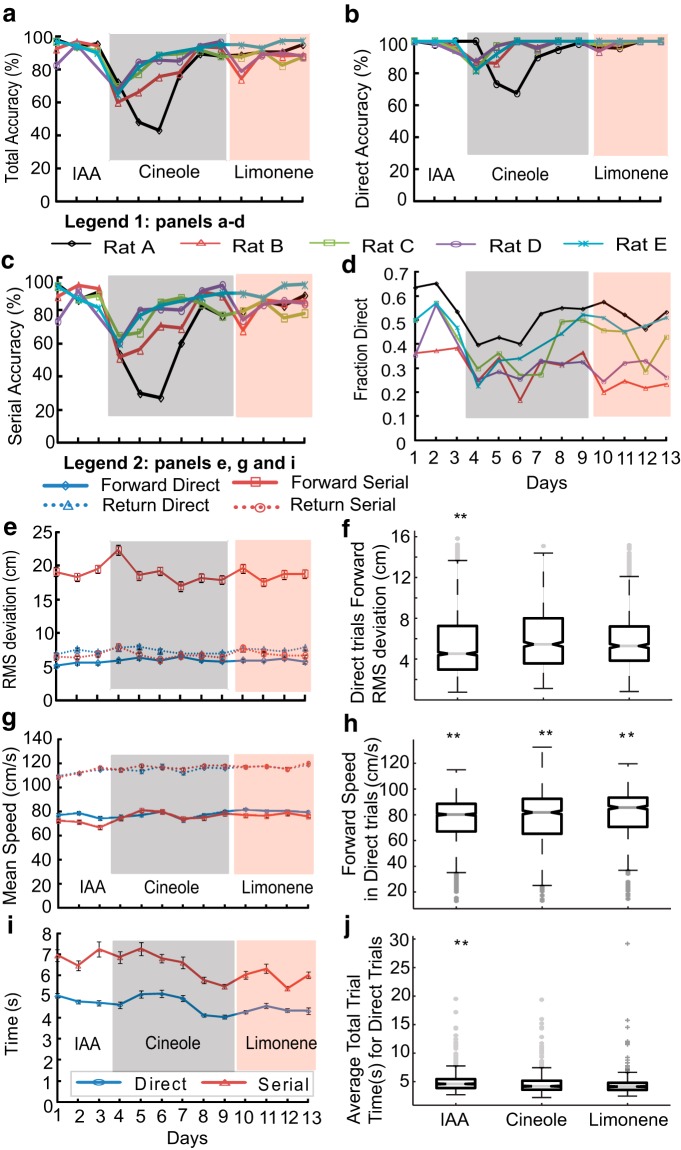
Rats rapidly learn to track novel odors. a–d, e, g, i, The white region represents baseline (IAA) odor delivery; gray region represents Cineole, and red represents Limonene. a, Total tracking accuracy. There is a major drop on introduction of cineole, a smaller one for limonene. b, Success rate in direct trials. There is a drop only in the first few days with cineole. c, Similar plot as b for serial trials. There is a big drop at the start of cineole. d, Fraction of trials using direct tracking for all rats. This drops toward chance during the initial few days with cineole. e, Average RMS deviation across all days for all rats. There is remarkably little increase for forward direct trials. f, Whisker box plot of RMS deviation in forward direction for direct trials. Data is pooled for all rats. Nd (IAA) = 1851, Nd (Cineole) = 921, Nd (Limonene) = 724. RMS values of days for Cineole and Limonene are significantly different from IAA but not from each other (**p < 10−10, KW Tukey HSD test). Gray line is the median. Lower and upper edges of the box represent 25th and 75th percentile. Whiskers represent the extreme data points and gray crosses are the outliers. g, Mean forward and return speeds for direct (blue) and serial (red) trials for all rats in the forward (solid lines) and return (dashed lines) direction. h, Whisker bar plot of the average mean speed for direct trials combined for days with IAA, Cineole and Limonene as tracking odor. All speeds are significantly different from each other (**p < 10−10, KW Tukey HSD test).Note that the speed distributions are positively skewed so the medians in the whisker plots are higher than the means from g. i, Total trial time averaged for all rats for direct (blue) and serial (red) trials. j, Whisker box plot for total trial times in direct tracking for IAA, Cineole, and Limonene days. Novel odors were significantly different from IAA, but not from each other (**p < 10−25, KW Tukey HSD test). Error bars on all line plots are SEM values.